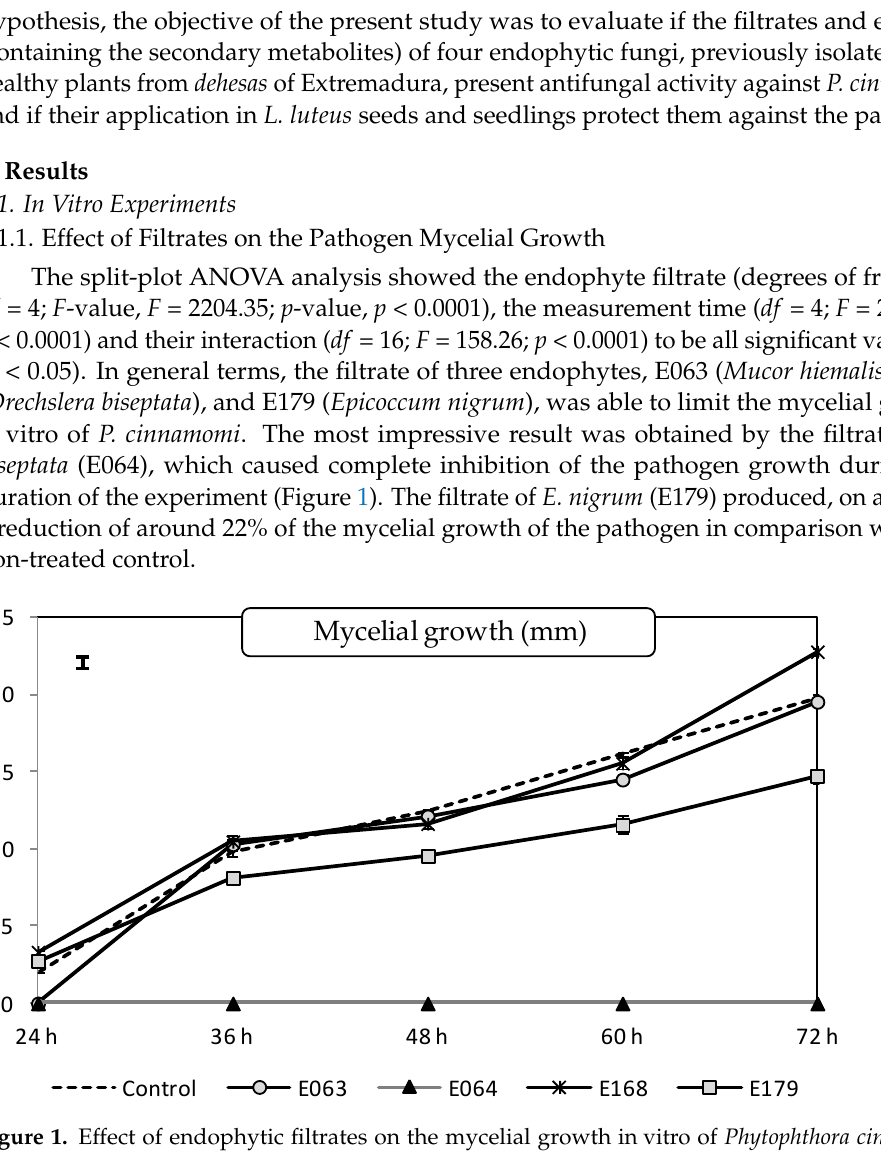
Figure 1. Effect of endophytic filtrates on the mycelial growth in vitro of Phytophthora cinnamomi colony over five measurements (after 24, 36, 48, 60, and 72 h). Values are expressed as mean (n = 16) ± standard error (error bars). The bar in the upper-left corner indicates the least significant difference (LSD) at α = 0 .05.